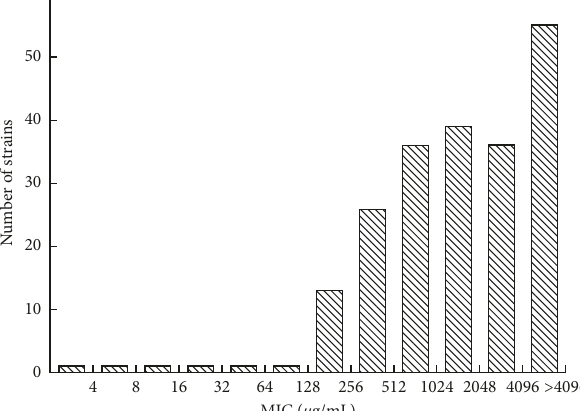
Figure 1: The MIC to ampicillin for 211 strains of P. aeruginosa had a high resistance